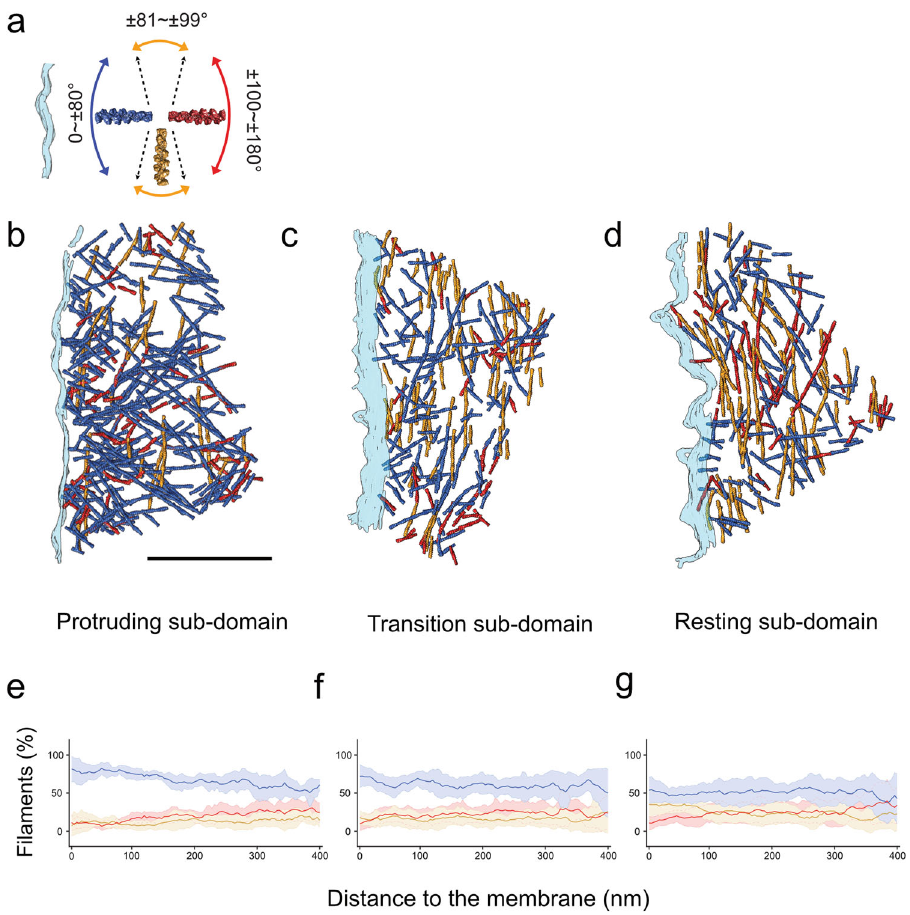
Fig. 4 Three different sub-domains within lamellipodia. a A color scheme indicating the angles between actin fi laments and plasma membrane (turquoise). b – d Surface rendered views of representative tomograms from the 3 different sub-domains with the actin fi laments colored according to their orientation with respect to the plasma membrane. Scale bar: 300 nm. e – g The fraction of the forward (blue), parallel (mustard), and backward (red) actin orientations as a function of the distance from the membrane are plotted as continuous lines, with a shaded error bar of data standard deviation, for protruding, transition, and resting sub-domains ( N = 10, 16, 21